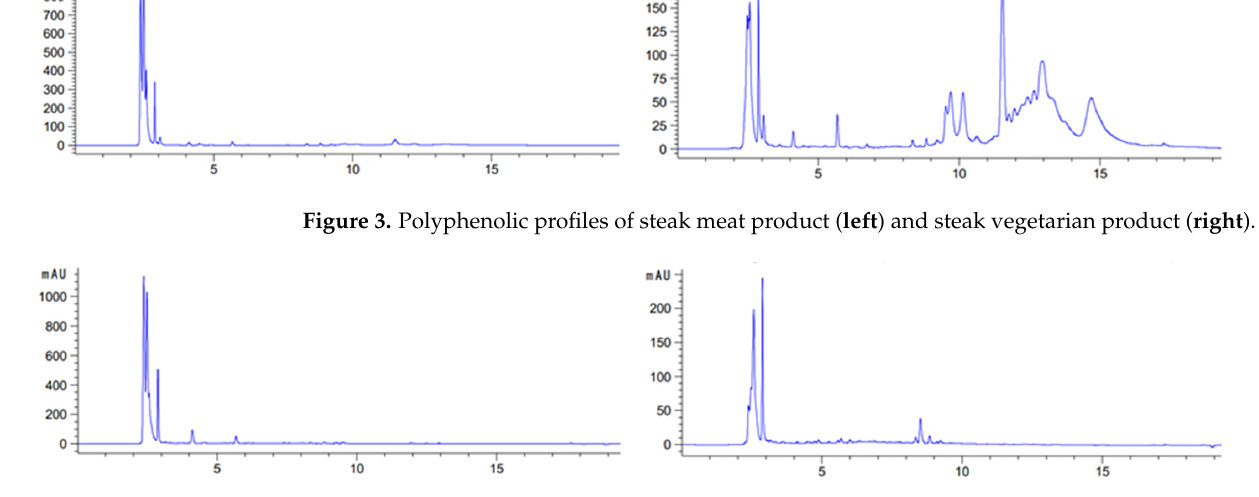
Figure 4. Polyphenolic profiles of Hungarian sausage meat product ( left ) and Hungarian sausage vegetarian product ( right ).